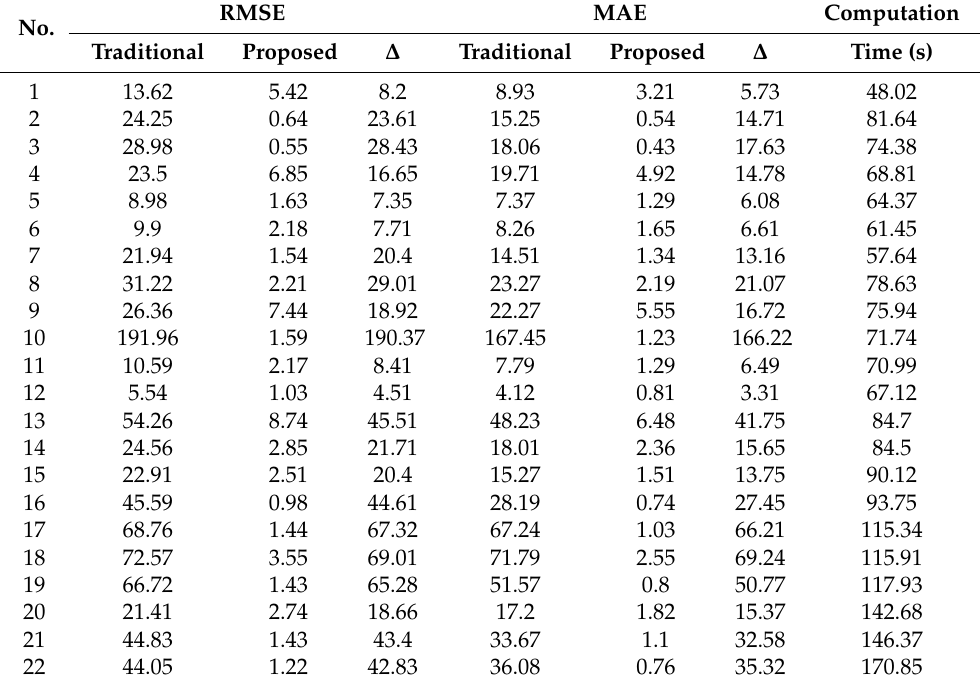
Table 6. Performance comparison for medium-term solar power forecasting (April) by the models. No.